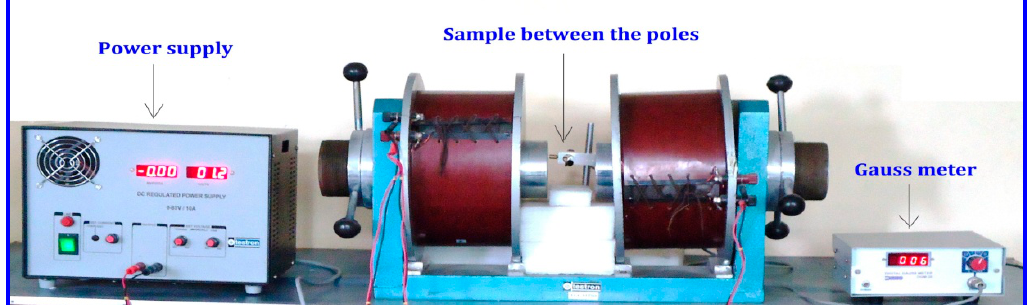
Figure 1. Electromagnetic field generator with variable magnetic field strength (50–500 mT) and a pole gap of 5 cm.